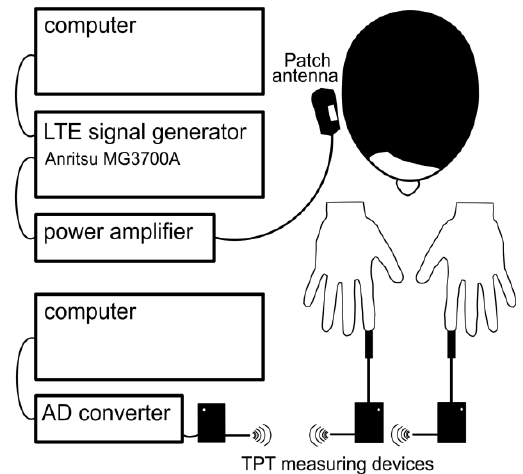
Figure 1. Experimental arrangement scheme. The LTE radiofrequency exposure system (top left) and the thermal pain threshold measuring device (bottom right).